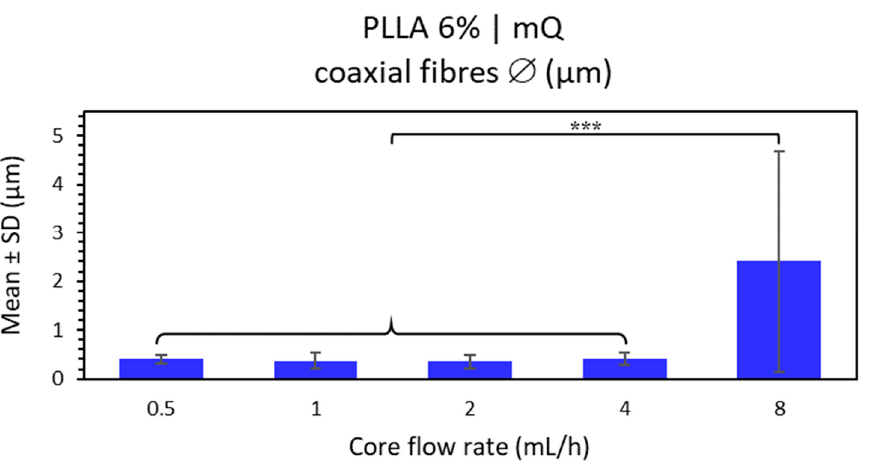
Figure 6. Mean and standard deviation of the diameters of PLLA 6% chloroform:DMF 80:20 (shell) and water mQ (core) coaxial microfibers manufactured at internal flow of 0.5, 1, 2, 4 and 8 mL/h, and water mQ (core) coaxial micro fi bers manufactured at internal fl ow of 0.5, 1, 2, 4 and 8 mL/h, external flow of 4 mL/h, with 15 cm and 15 kV, at (***) p < 0.001 statistically significant difference. external fl ow of 4 mL/h, with 15 cm and 15 kV, at (***) p < 0.001 statistically signi fi cant di ff erence. C-ES Microfibers of PLLA 6% 80:20 | PVA 8% as a Function of Inner Flow Rate and C-ES Micro fi bers of PLLA 6% 80:20 | PVA 8% as a Function of Inner Flow Rate and Volt- age